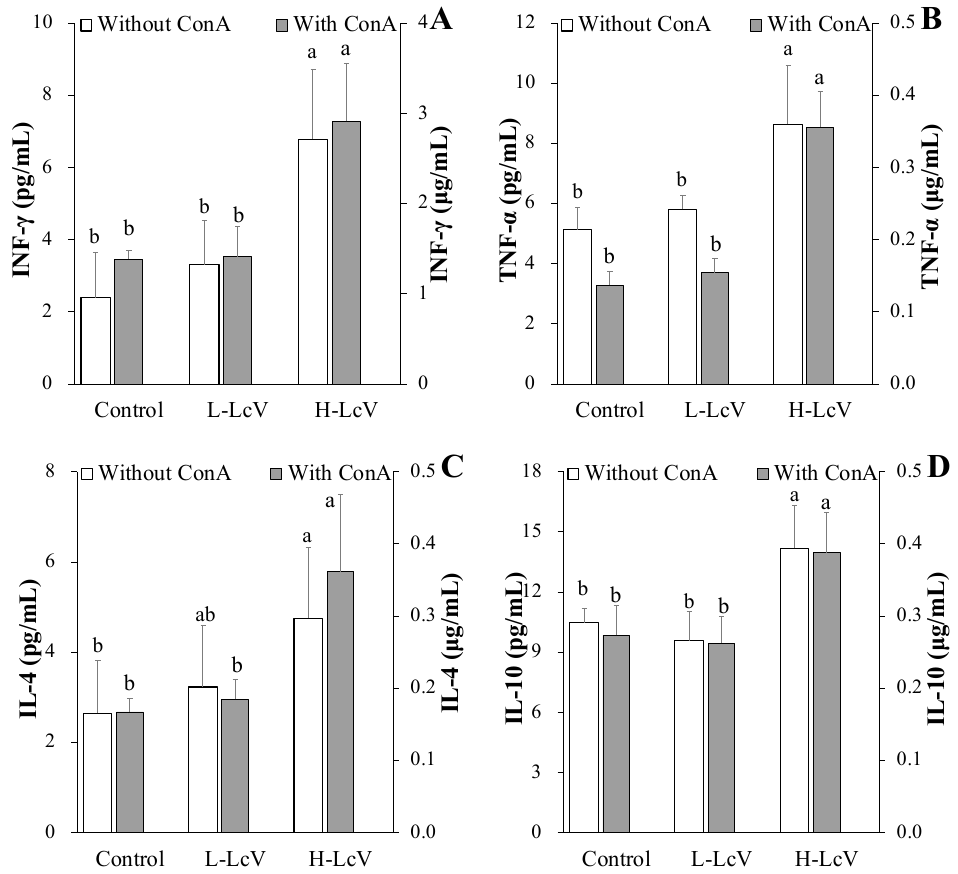
Figure 4. Splenocyte ( A ) INF- γ , ( B ) TNF- α , ( C ) IL-4, and ( D ) IL-10 of mice administered with Ll. curvatus -derived ECVs (LcV) for 10 days. LcV orally treated for 10 days (once/day) at the concentrations of 0.1 mg/kg BW (L-LcV) and 1 mg/kg BW (H-LcV). Isolated splenocyte were stimulated with mitogen (ConA or LPS) for 24 h or 48 h. Values are expressed as the mean ± SD ( n = 6) and those followed by different letters (a,b) within a property are significantly different ( p < 0.05) according to Duncan’s multiple range test.